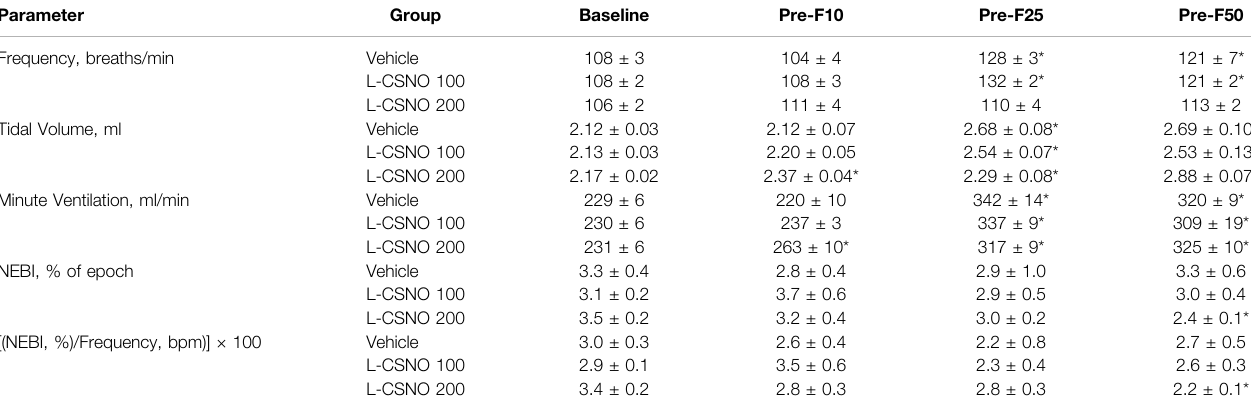
TABLE 2 | Baseline parameters at the beginning of the experiments (Pre) and prior to each injection of fentanyl (F10, F25, and F50) in the L-CSNO infusion experiments. Parameter Group Frequency, breaths/min